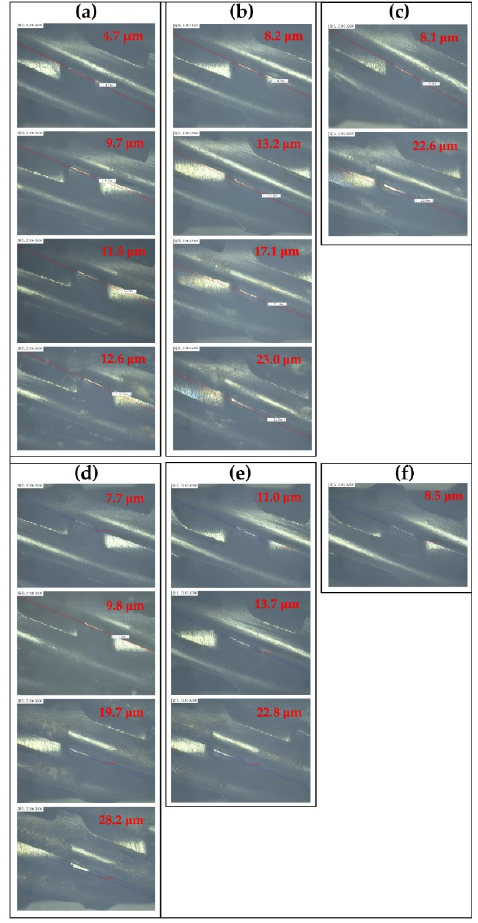
Figure 14. Typical wear patterns of the cutting edges of coated milling cutters with different milling